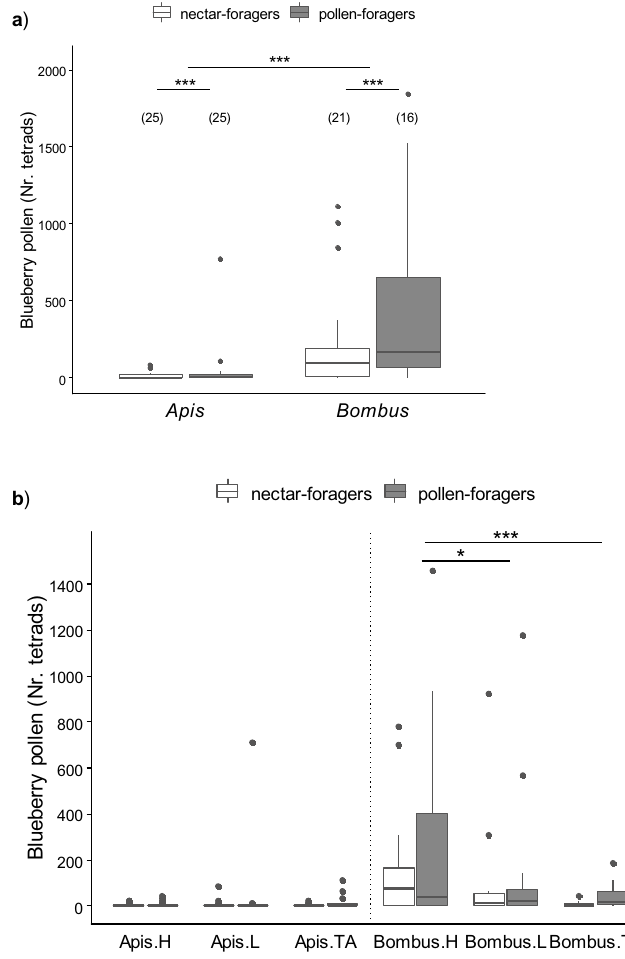
Figure 3. Blueberry pollen on Apis mellifera and Bombus pauloensis. (a) Tetrad counts on the body of foragers. Bumblebees carried ten times more blueberry pollen on their body than honeybees, and significantly more tetrads were found on pollen- than on nectar-foragers. ( b ) Tetrad counts on head (H), legs (L) and thorax- abdomen (TA) of foragers. While bumblebees carried more blueberry pollen on their head, the amount of tetrads on honeybees did not differ between the regions evaluated. Boxplot shows the median and interquartile range (IQR), with whiskers showing the maximum value within 1.5 IQR, and individual points mark values outside this range. Asterisks indicate statistical differences (*, p < 0.05; ***, p < 0.001). Sample size indicated between